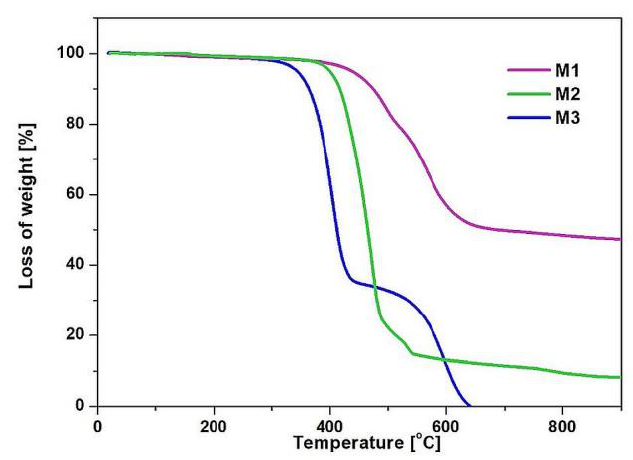
Figure 1. Thermal properties of M1–M3 .